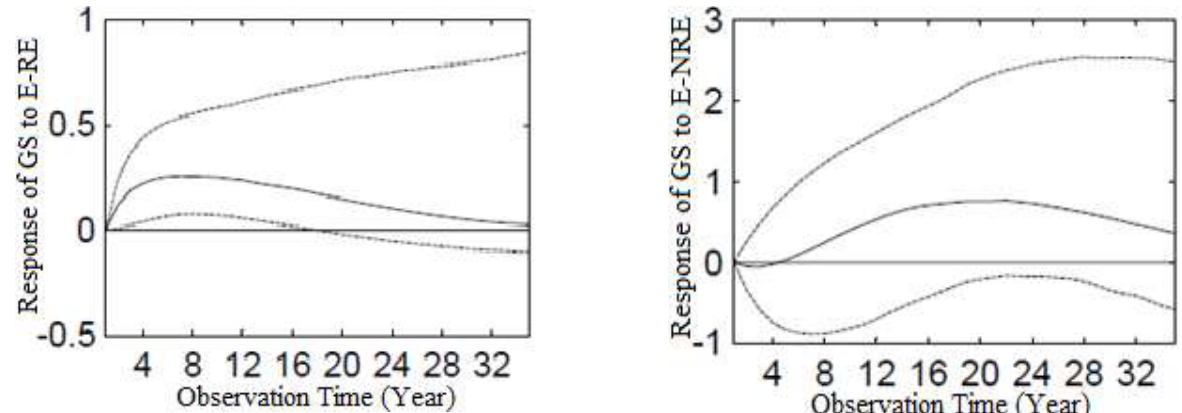
Figure 1. The impact of renewable and non-renewable energy shock on sustainable development Source: Research